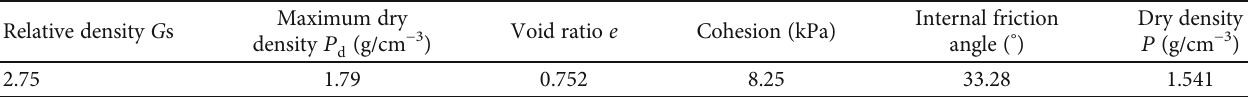
Table 2: Tailing sand engineering physical and mechanical